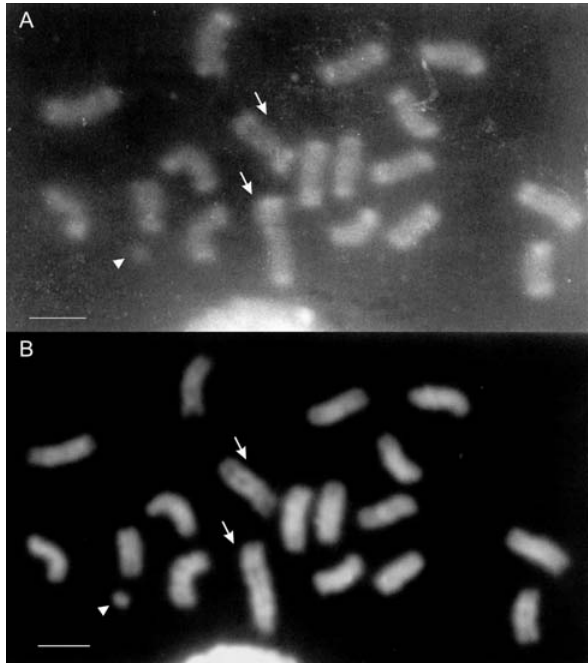
Figure 3 - Sequential staining with CMA 3 /DA/DAPI in metaphases of Melipona rufiventris (A: CMA 3 ; B: DAPI). The arrows indicate chromo- some pair 1 and the arrowhead indicates the B chromosome. Scale bar = 5 μ